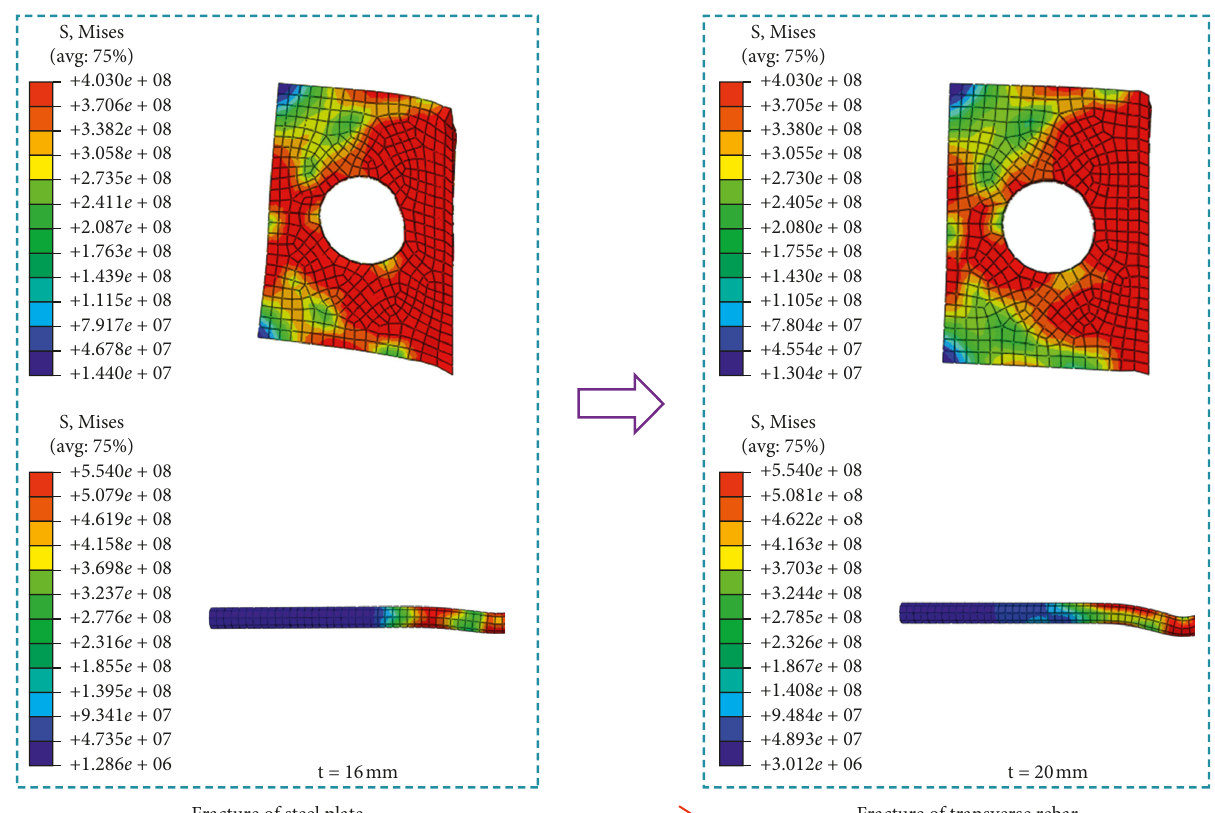
Figure 12: Failure patterns for PBL with different plate